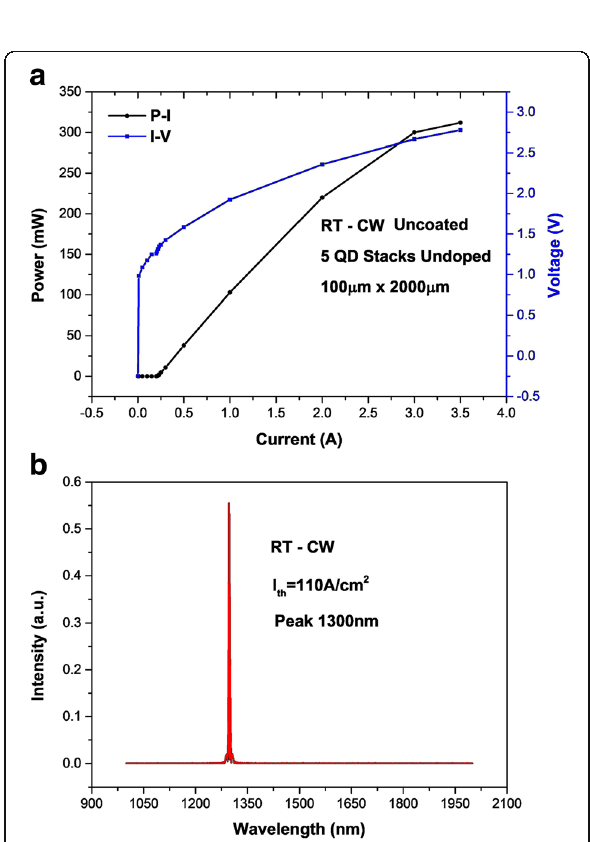
Fig. 6 Device measurements. a P-I-V curves of a QD laser. b The lasing wavelength is 1.3 μ